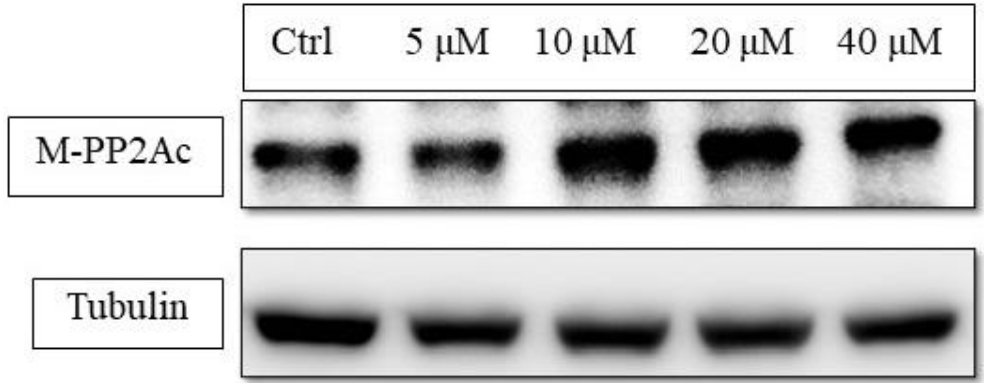
Figure 5. The concentration-dependent study of PP2Ac methylation status under 6,7-diprenoxycoumarin ( 50 ) treatment. Hep3B cells (1 × 10 6 ) were treated with 50 (5, 10, 20 and 40 µ M) for 24 h. Treated cell lysates were prepared as described in the Methods section and methyl-PP2Ac expression was analyzed by western blot.